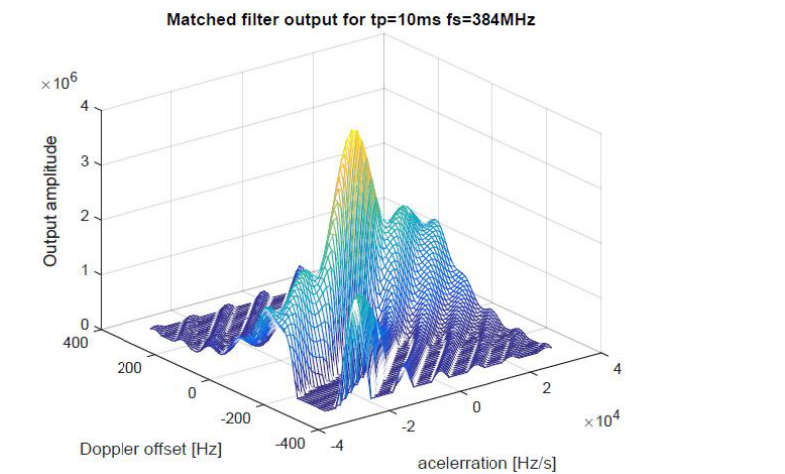
Figure 8– FIR filter outputs for different velocities and high accelerations Рис. 8 – Выход КИХ-фильтра при различных скоростях и сильном ускорении Слика 8 – Излаз из FIR филтера при различитим брзинама и великим